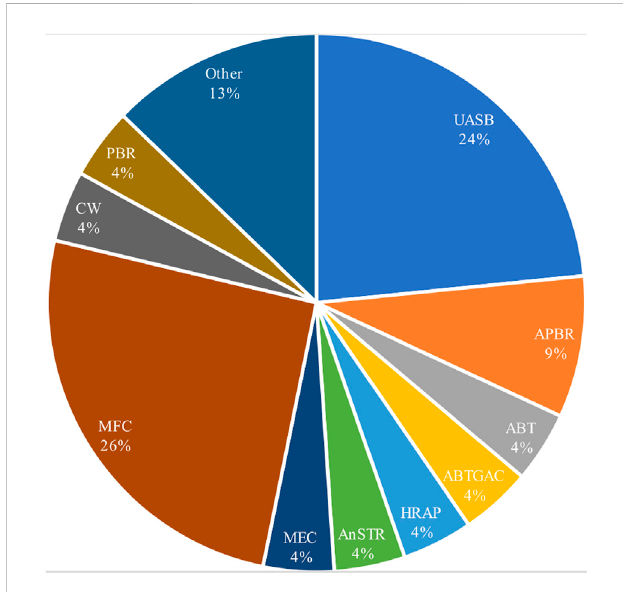
FIGURE 3 Different technologies for wastewater treatment and energy recovery researched in Mexico.